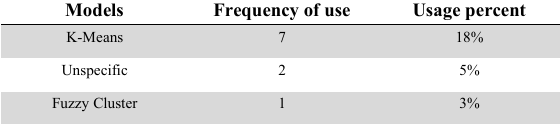
Comparison of the clustering methods